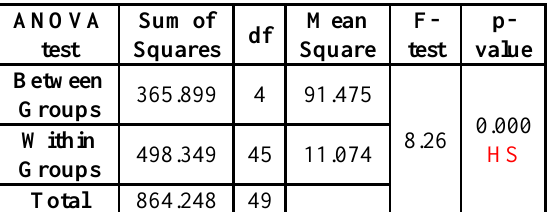
Table 2: ANOVA test for the nanoleakage